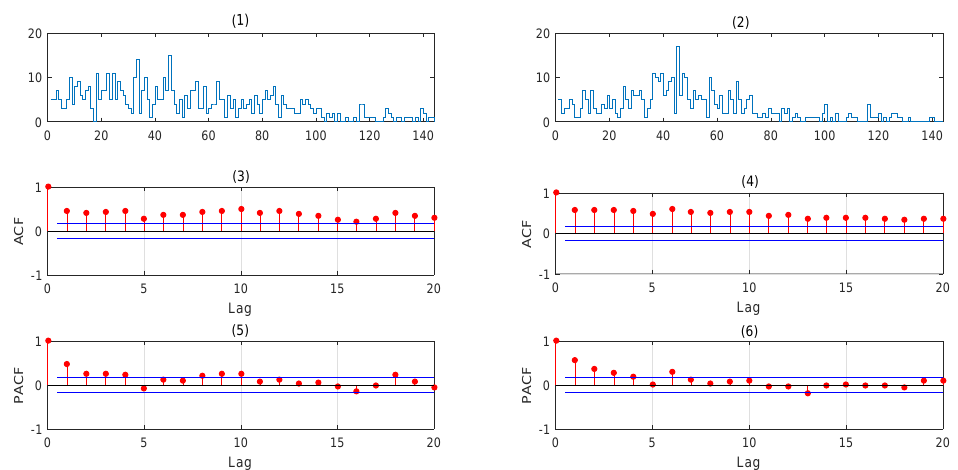
Figure 6. Beat 26: ( 1 ) monthly number of burglaries, ( 2 ) monthly number of robberies, ( 3 ) ACF of burglaries, ( 4 ) ACF of robberies, ( 5 ) PACF of burglaries, ( 6 ) PACF of robberies.